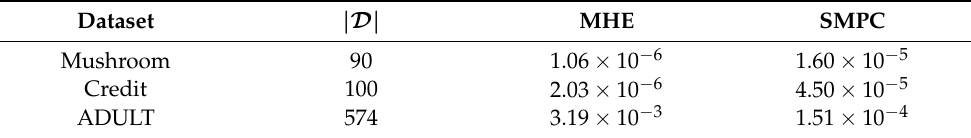
Table 10. Relative error (%) of calculating χ 2 -statistic in the secure federated χ 2 -test on various datasets.